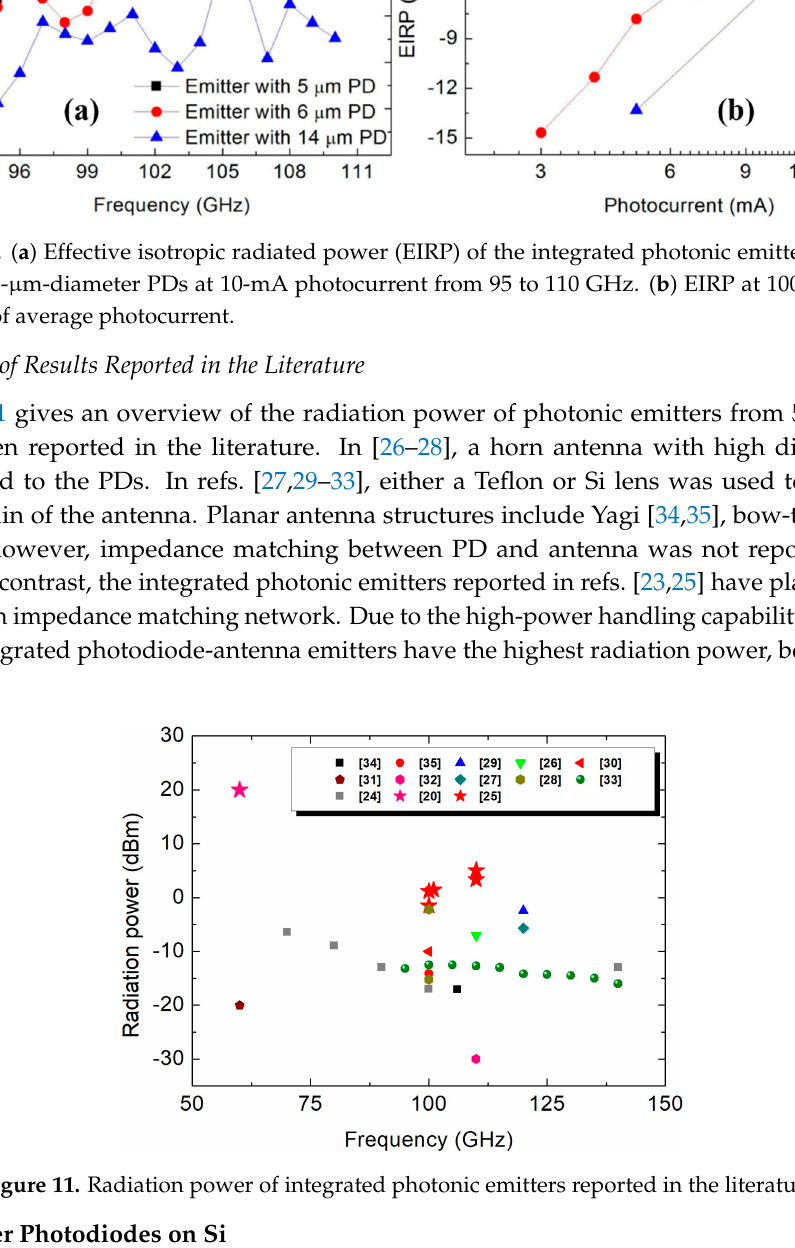
Figure 9. Experimental setup for measuring the radiation power of the photonic emitter at W-band. LO: local oscillator. The distance between photonic emitter and horn antenna was 60 cm.